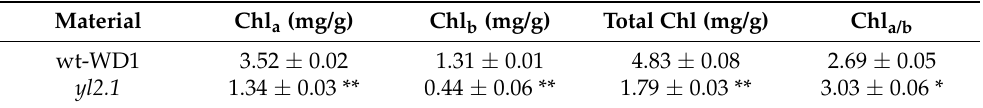
Table 2. Chlorophyll content of young leaves of the yl2.1 and the wt-WD1 For each sample, five independent biological replications were performed. Each independent biological replication contains three different individuals. Three technical repeats were performed for each biological replication. Data are means ± SD ( n = 5). Asterisks indicate statistically significant differences compared with the wild-type at ** p < 0.01 and * p < 0.05 by Student’s t -test.